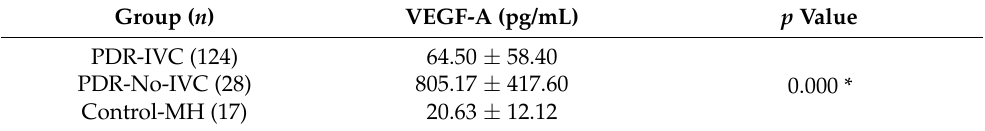
Table 2. VEGF-A level in vitreous between different groups (x ±